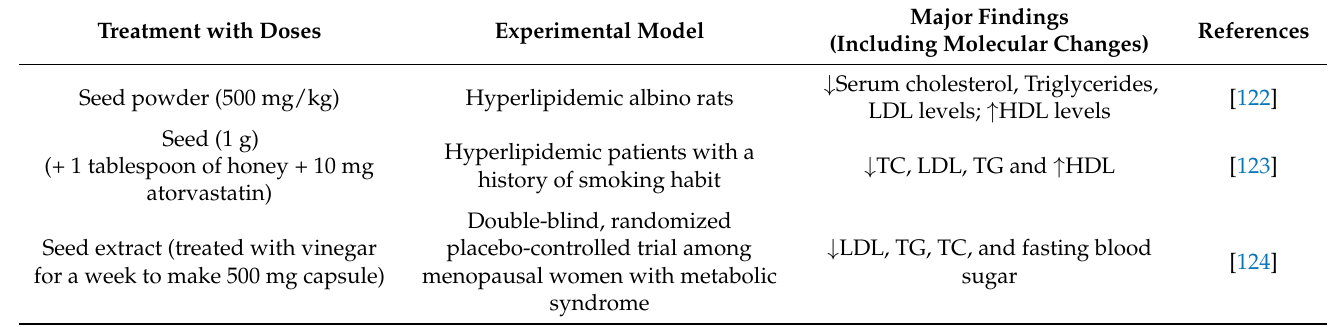
Table 3. Comprehensive summary on the anti-obesity and anti-dyslipidemia effects of black cumin. Treatment with